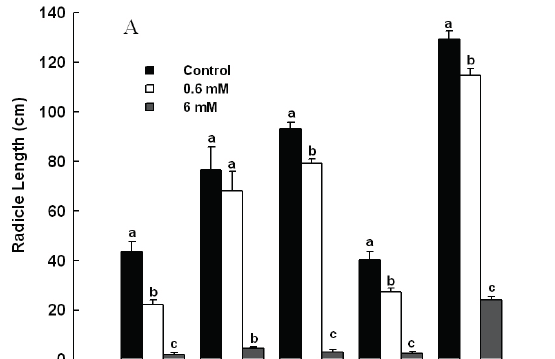
Figure 6. Effects of 4,8-DHT on five plants seedling growth: ( A ) radicle length; ( B ) plumule length; ( C ) fresh weight of seedling. Data are the mean ± SD values (n = 3 per group). Final means with different letters are significantly different at p =